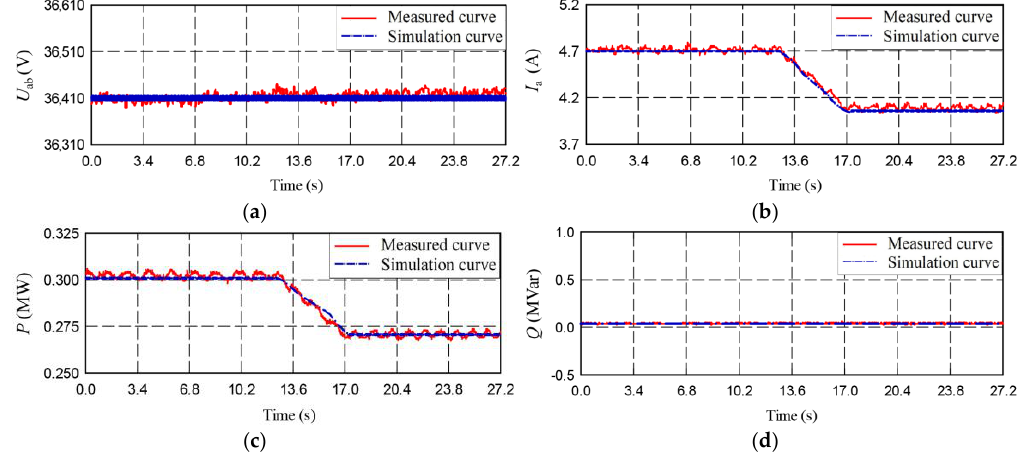
Figure 16. Measured identification curve of inverters under a step disturbance of active power: ( a ) AB phase voltage; ( b ) A phase current; ( c ) Active power; ( d ) Reactive power.